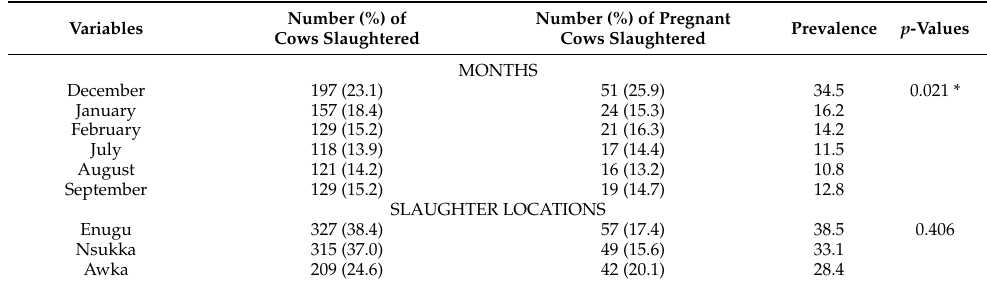
Table 4. Spatial and temporal distribution of pregnant cows ( n = 148) slaughtered in major slaughter- houses in South-East